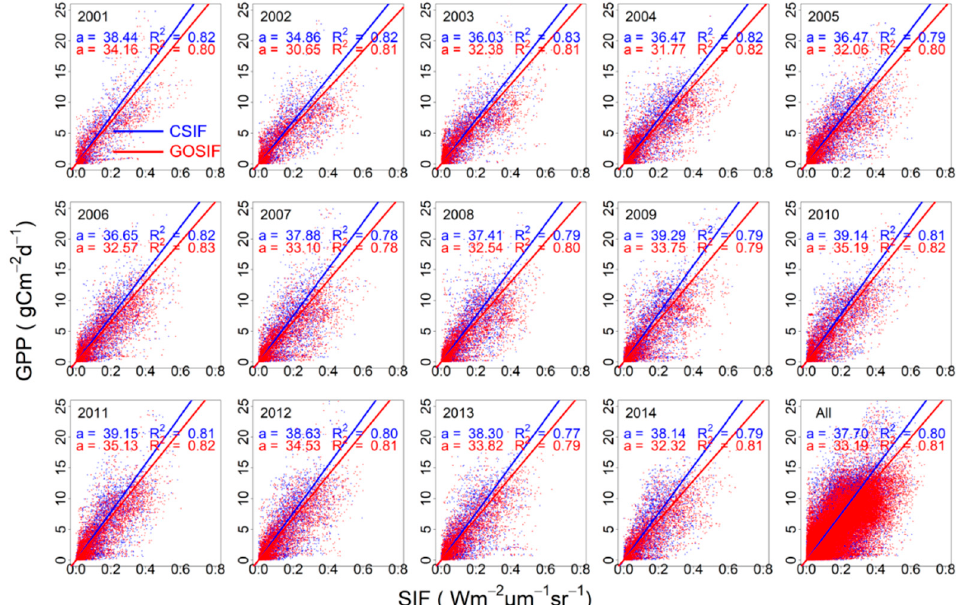
Figure 7. Scatter plots and linear regression of GPP and SIFc (CSIF and GOSIF) for all 12 biome types year by year at a daily scale ( p < 0.001). The statistical measures for the linear regression listed in the top left corner correspond to different colors. All the linear regressions were forced to go through the origin. Years range from 2001 to 2014, and the last figure shows all the matched daily SIFc-GPP data.